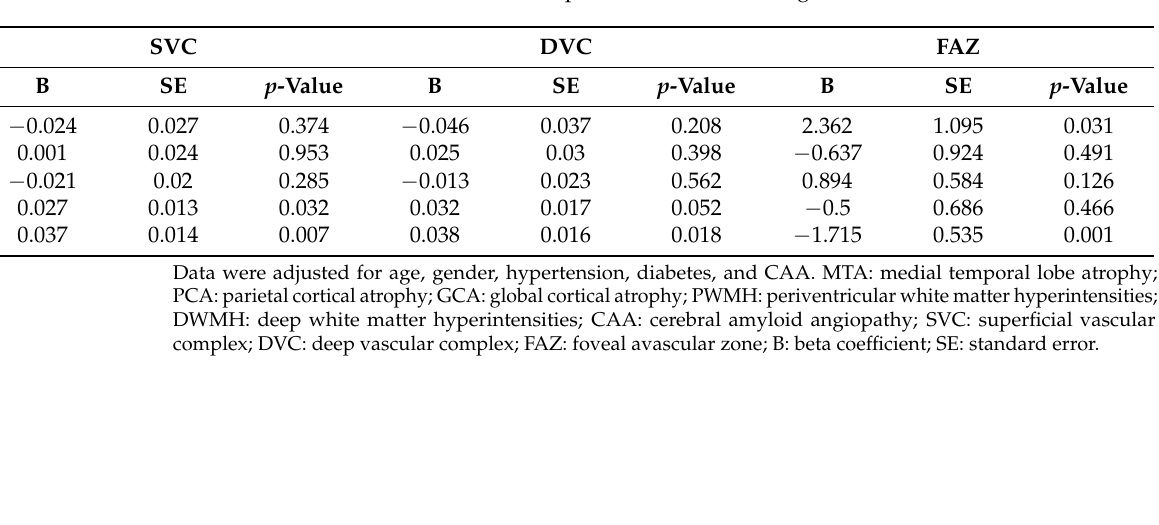
Table 2. Correlation between SS-OCTA parameters and radiological indicators of